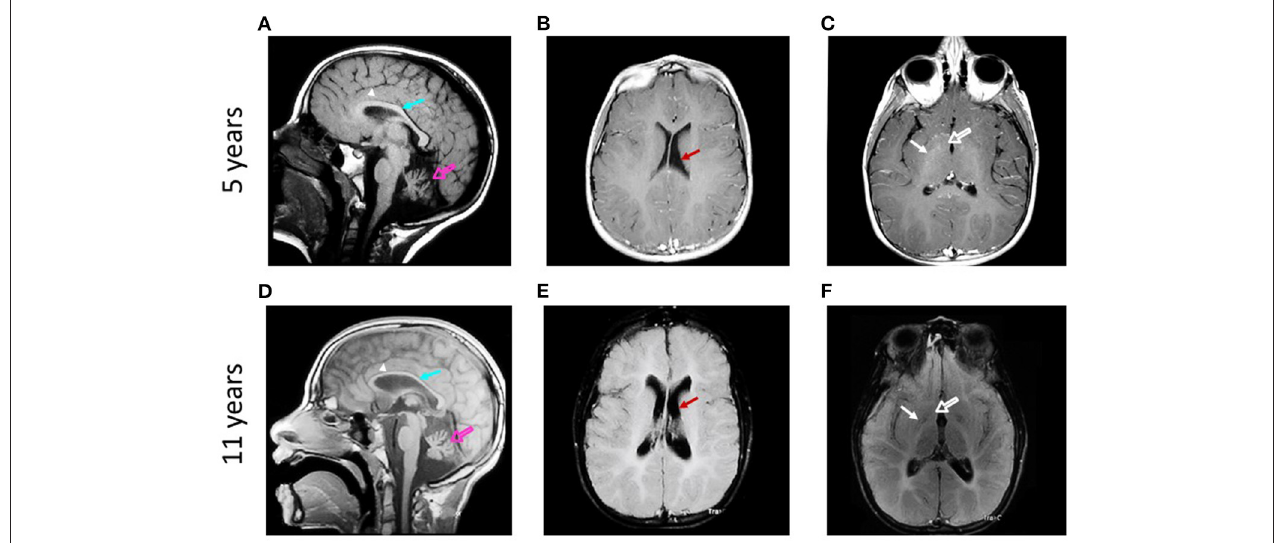
FIGURE 1 | Qualitative analysis of the evolution of brain structures in a patient suffering from H-ABC. Sagittal T1-weighted magnetic resonance images obtained at 5 (A) and 11 years (D) show atrophy of cerebellum (open arrows) and corpus callosum (arrows) and involvement of U-fibers (arrowheads). Axial T2-FLAIR-weighted magnetic resonance images obtained at 5 (B,C) and 11 years old (E,F) show atrophy of the brain cortex and ventriculomegaly [arrows in (B,E)] . Atrophy of caudate (open arrows) and putamen (arrows) is also observed (C,F)